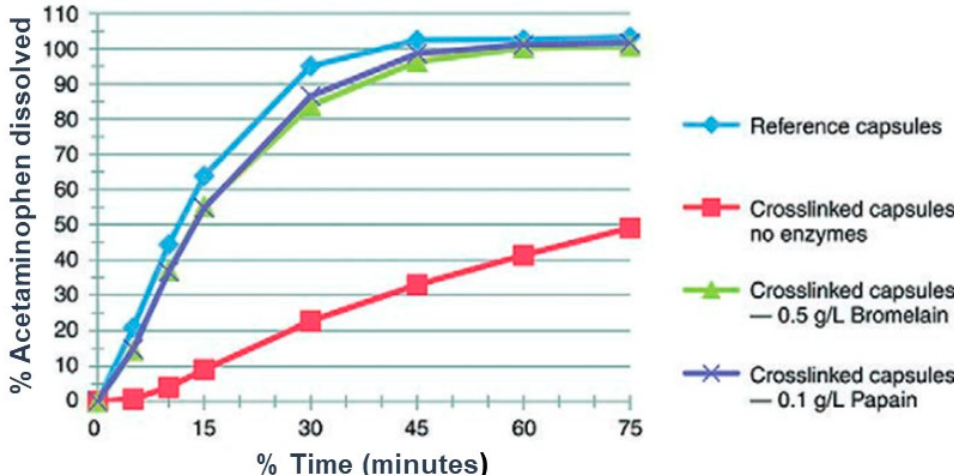
Figure 12. Dissolution profiles of cross-linked gelatin capsules using the enzymes bromelain and papain in pH 6.8 phosphate buffer. The solid blue line is the dissolution profile on non-cross-linked gelatin capsules (reference capsules) containing acetaminophen in pH 6.8 phosphate buffer. Reproduced with permission from [127], Dissolution Technol., 2014.